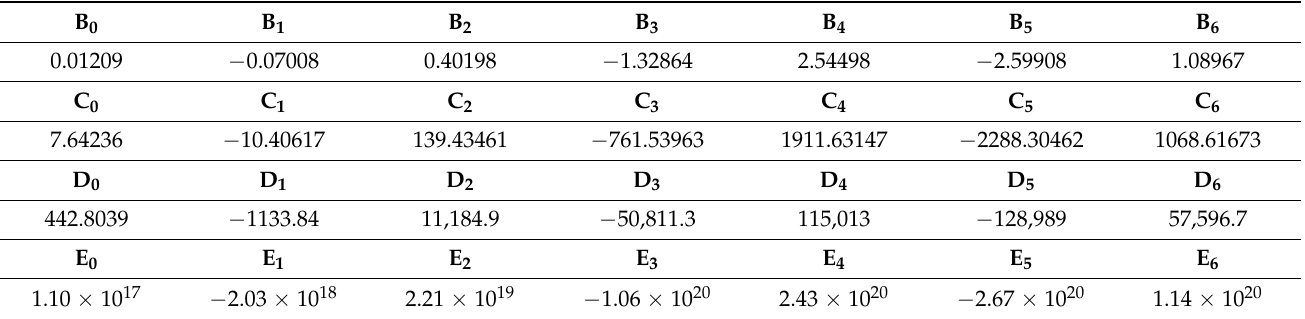
Table 5. Polynomial coefficients of material parameters.